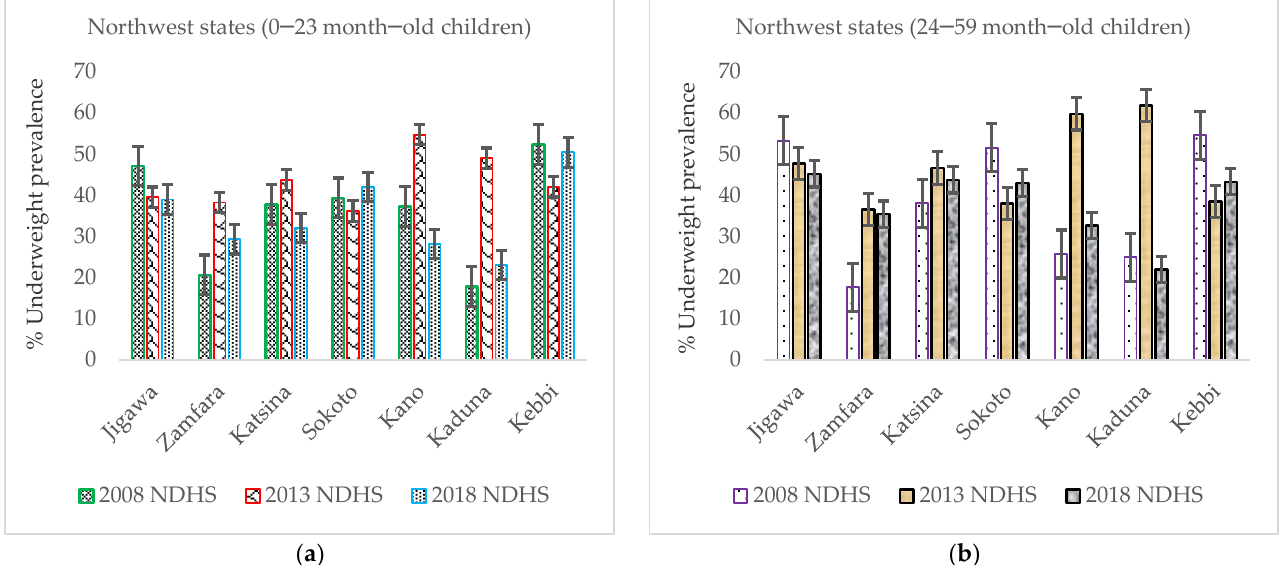
NDHS, with a 95% by northeast states.